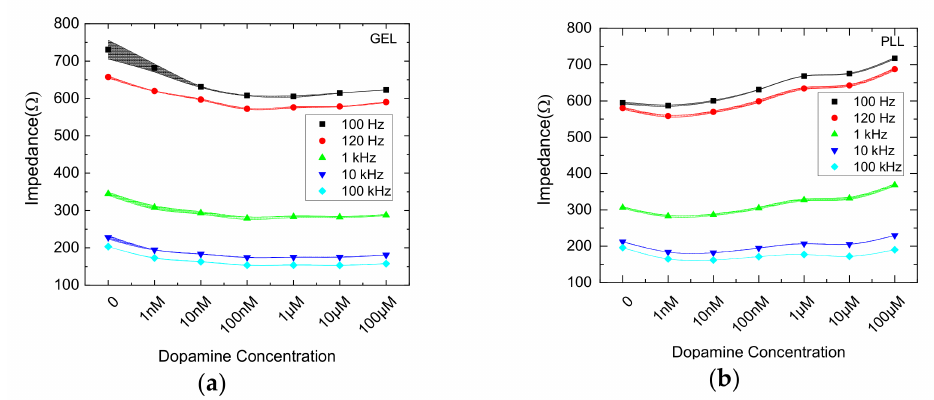
Figure 3. Comparison of mean impedance magnitude values for cells in 3D (GEL) ( a ) and 2D (PLL) ( b ) cultures treated with DA at five different frequencies (100Hz/ 120Hz/ 1KHz/ 10KHz/ 100KHz), with ± SD values.